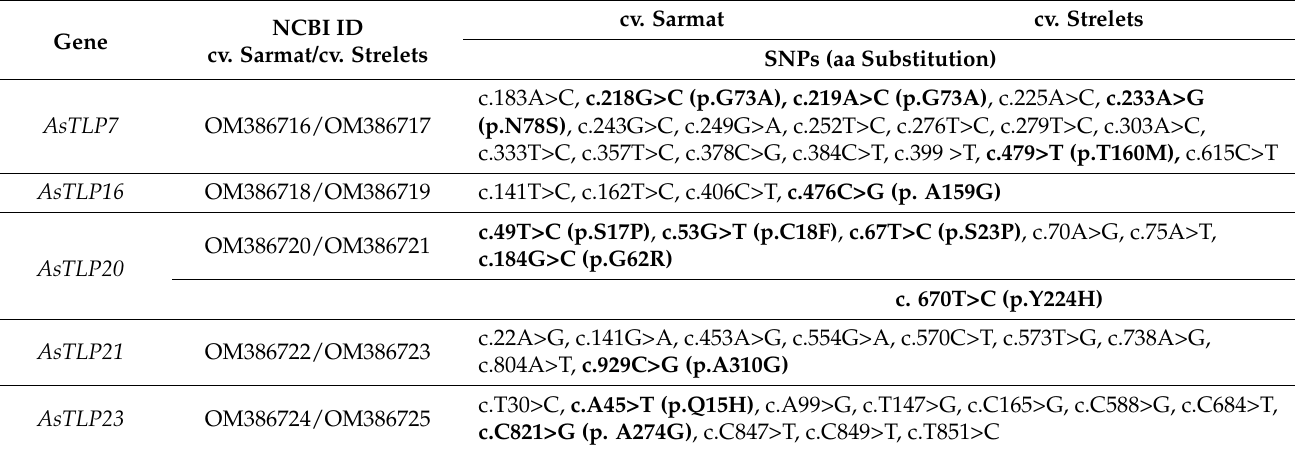
Table 2. Polymorphisms in the AsTLP CDSs of cv. Sarmat and Strelets compared to cv. Ershuizao.